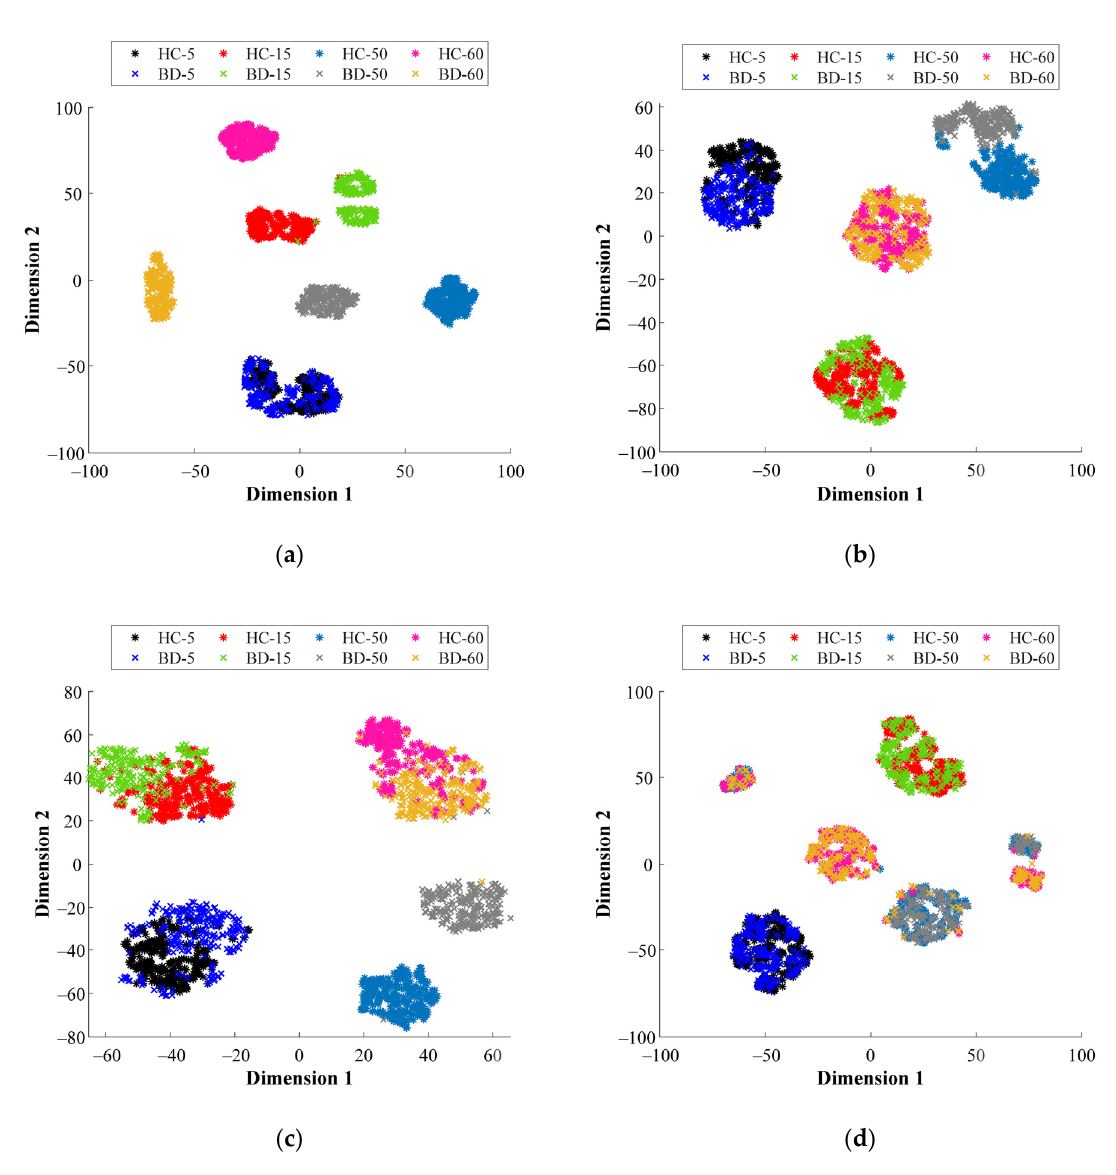
Figure 9. Two-dimensional visual representations of the data distribution achieved by the T-SNE technique over the resulting feature spaces mapped by their corresponding SAE of the metallic bearing when analyzing: ( a ) vibrations signals in FD, ( b ) stator current signature in FD, ( c ) vibrations signals in TFD and ( d ) stator current signature in TFD.